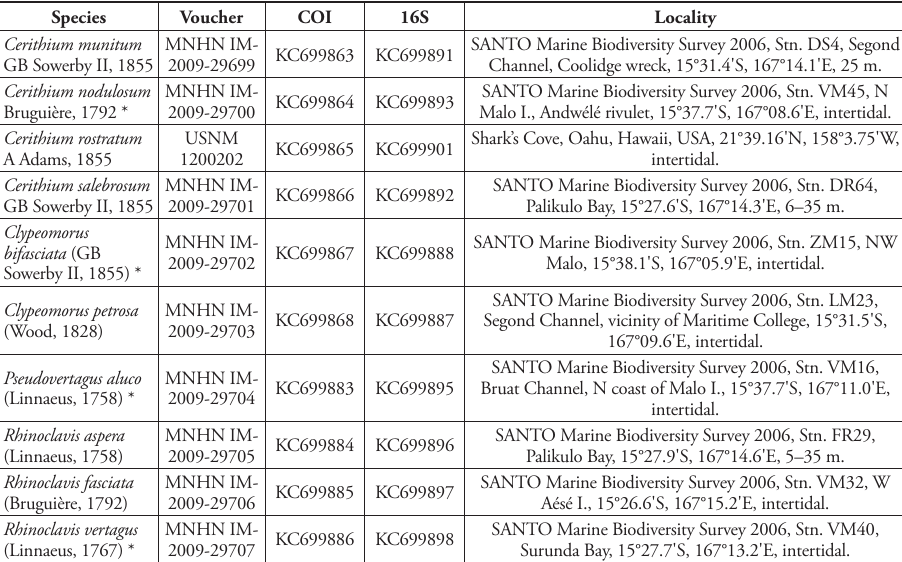
Type material. Holotype UF 427943 (Biocode No. MBIO19550, Specimen No. BMOO-03501,) (Fig. 2A, H); paratypes as listed